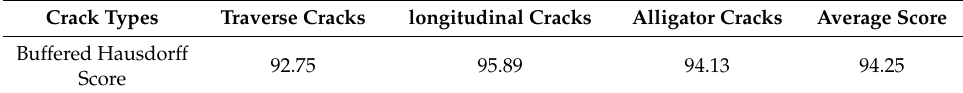
Figure 13. Sparse components and the corresponding pavement alligator cracks information, ( a ) 3D pavement data, ( b ) the corresponding sparse components, ( c ) crack information, ( d ) crack ground truth information. Table 1. Buffered Hausdorff scores of test data in Figures 11–13. Table 1. Buffered Hausdorff scores of test data in Figure 11–13